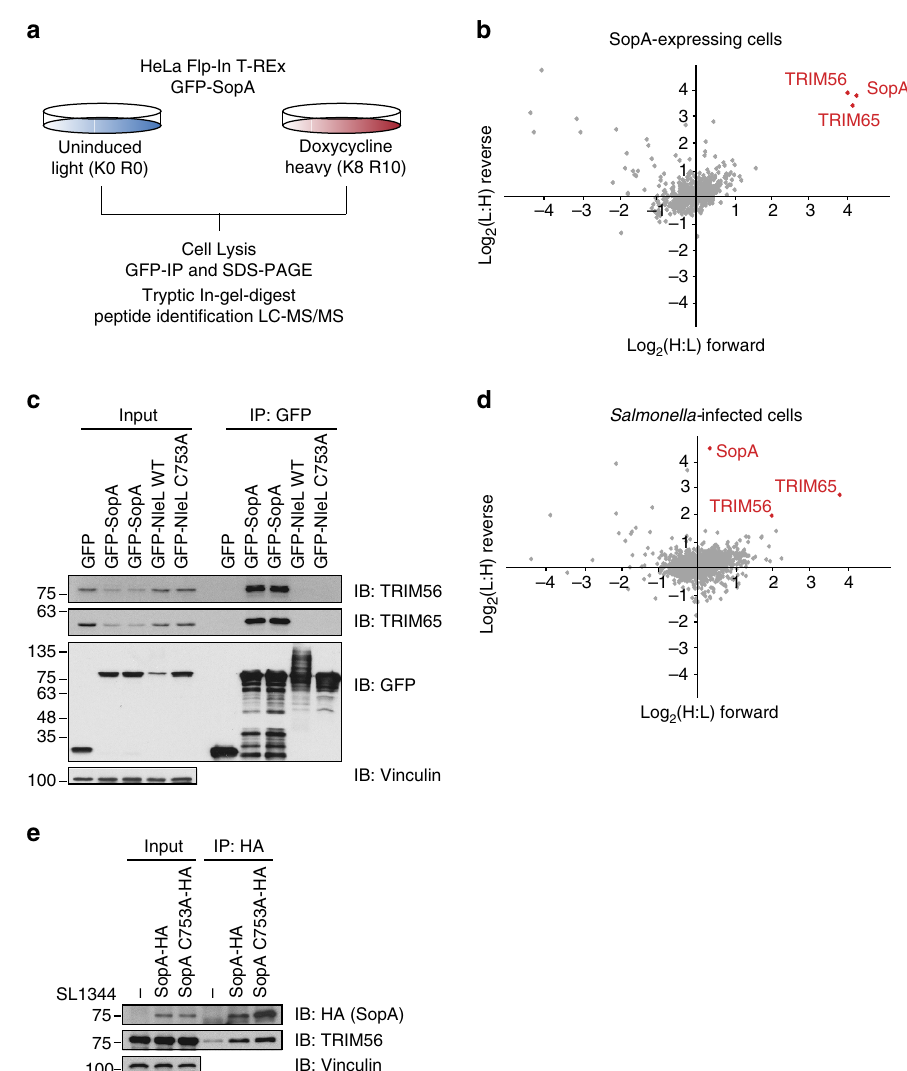
Figure 1 | Identification of TRIM56 and TRIM65 as SopA-interacting proteins. ( a ) Workflow for SILAC-coupled SopA interactome analysis from inducible HeLa Flp-In T-REx GFP-SopA-expressing cells. ( b ) SopA interacts with TRIM56 and TRIM65. Scatter plot of forward and reverse SILAC SopA interactome. Proteins situated in the upper left quadrant include contaminants. ( c ) Endogenous TRIM56 and TRIM65 specifically interact with SopA. Lysates from HEK293Tcells expressing GFP, GFP-SopA or GFP-NleL constructs were subjected to anti-GFP IP, followed by SDS–PAGE and immunoblotting. ( d ) Bacterially translocated SopA interacts with TRIM56/65. Scatter plot of forward and reverse SILAC interactome experiments from Salmonella- infected HeLa cells. Proteins situated in the upper left quadrant include contaminants. ( e ) Endogenous TRIM56 interacts with bacterially secreted SopA during infection. Lysates from HeLa cells infected with SL1344 WT, SopA–HA or catalytic-dead SopA C753A-HA-expressing strains were subjected to anti-HA IP, followed by SDS–PAGE and